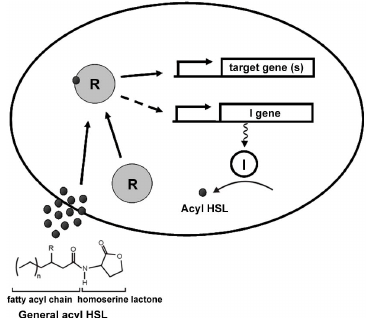
Figure 1. Basic model of quorum sensing (QS) circuits. The eclipse represents a cell. The I gene represents the luxI homologue. R represents the acylated homoserine lactone (AHL) receptor LuxR protein. The dark unfilled circle represents the LuxI enzyme while the dark solid dots represent the AHL molecules. Stalked arrows indicate the transcription of the genes and the dotted line with arrow shows the positive feedback by the complex of the LuxR receptor and AHLs on the AHL synthase gene. The solid line with arrow depicts the function of R complex on the target genes. Squiggly line indicates translation of I gene and solid curved line with arrow indicates enzymatic function of I gene. The left corner shows the basic structure of a typical AHL molecule. N can vary from 4 to 18. R can be oxo, OH or